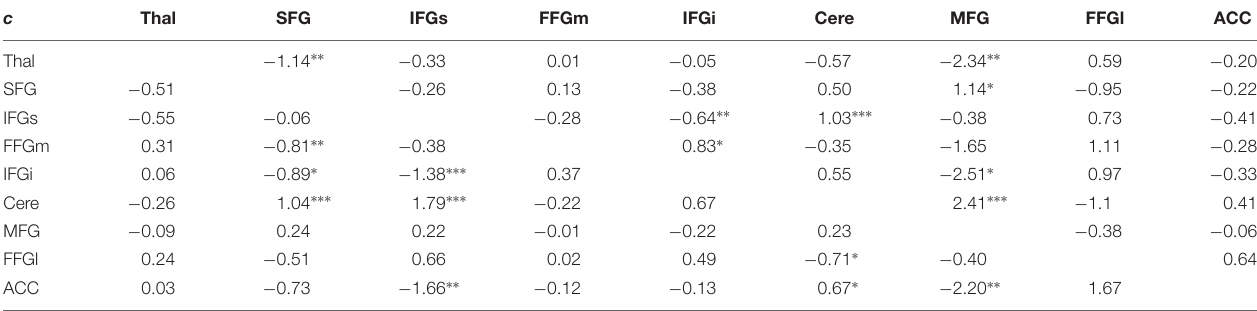
TABLE 1 | Group means of linear connectivity coefficients ( c